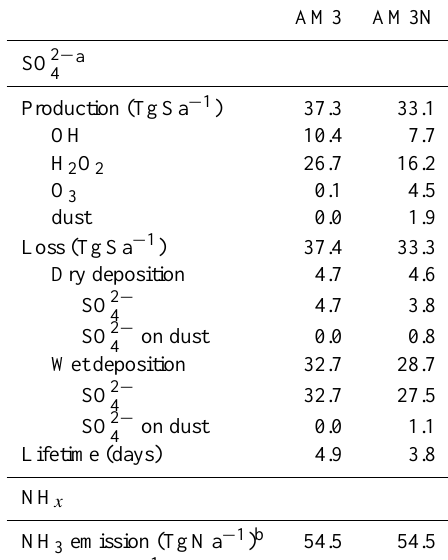
Table 1. Simulated budget of SO 4 , NH x , and NO y in 2010.